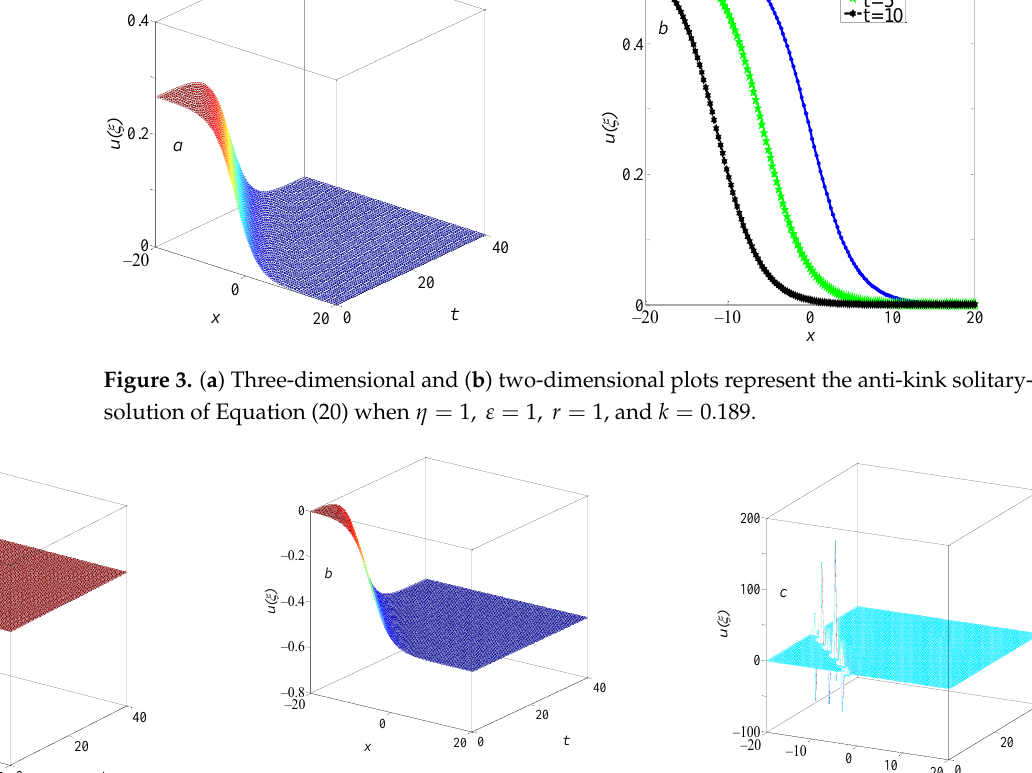
6𝑘 2 𝐴 where 𝜉 = 𝑘𝑥 + 𝜆𝑡 , 𝜆 = − , 𝑘 = ± , and 𝑟 ≠ 0 . Since r can take any number that is 𝜂 2 2 not zero, essentially, these two sets of solutions and Equations (20) and (21) represent the same type of solitary-wave solutions. Figure 4. Three-dimensional plots of the solutions of Equation (28) when η = 1 and ε = 1; ( a ) k = 0.189 Figure 4. Three-dimensional plots of the solutions of Equation (28) when 𝜂 = 1 and 𝜀 = 1 ; ( a ) 𝑘 = and r = 0; ( b ) k = − 0.189 and r = 2; and ( c ) k = 0.189 and r = 0.189 and 𝑟 = 0 ; ( b ) 𝑘 = −0.189 and 𝑟 = 2 ;and ( c ) 𝑘 = 0.189 and 𝑟 = 2 .